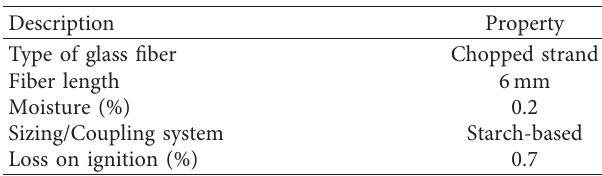
Table 1: Properties of glass